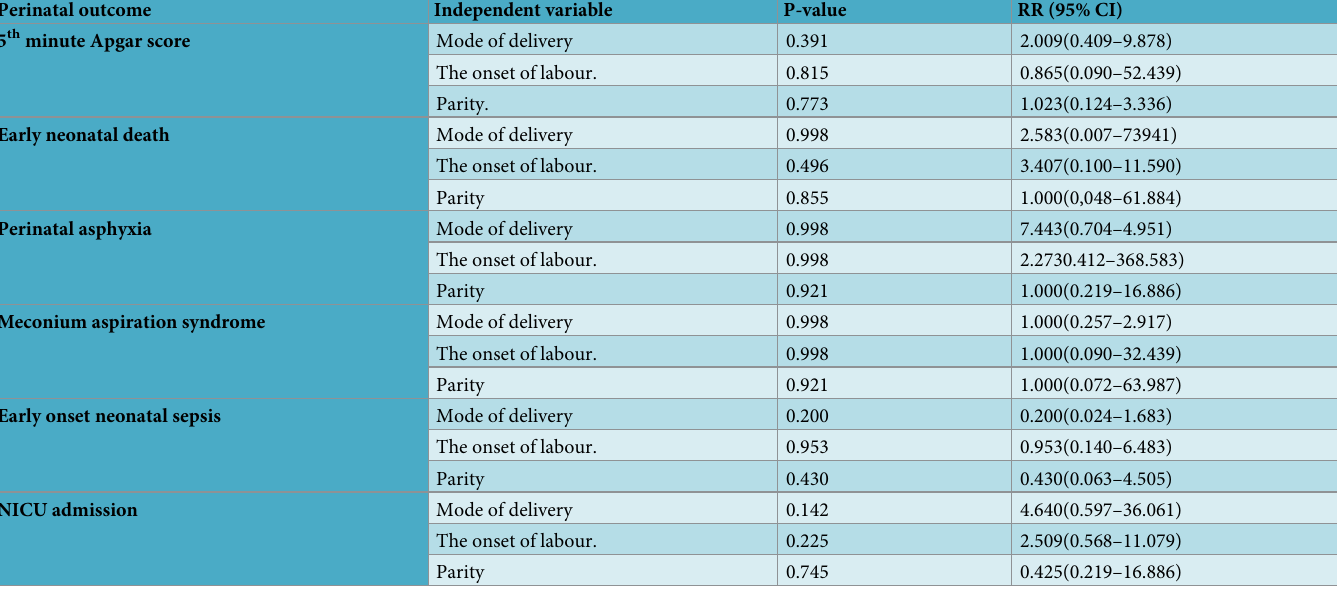
Table 5. Binary logistic regression of variables associated with meconium staining and perinatal